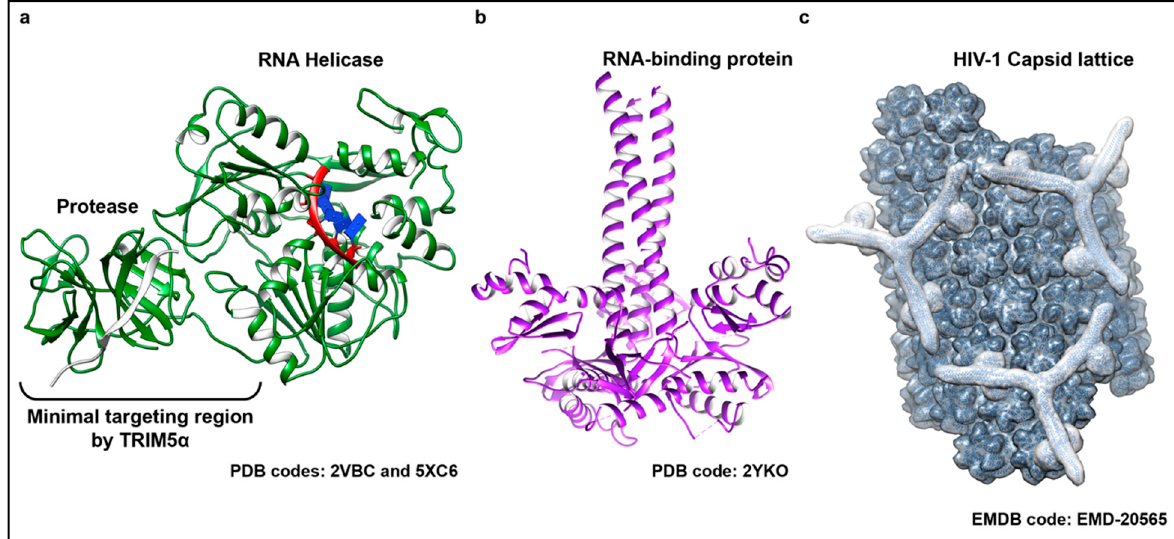
Figure 2. The structurally diverse substrates detected by TRIM5 α . TRIM5 α has been shown to target and respond to viral proteins belonging to evolutionarily divergent virus families. ( a ) Representative structure of the active RNA helicase